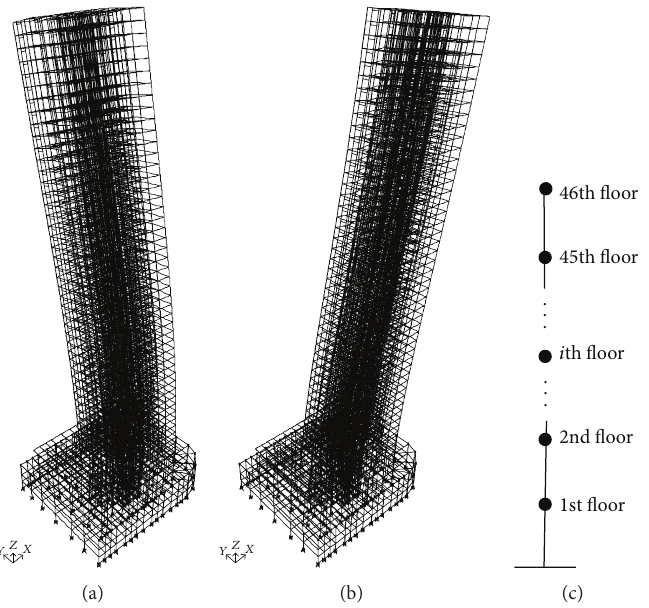
Figure 3: Structural diagram: (a) the first vibration mode; (b) the second vibration mode; (c) the lumped mass